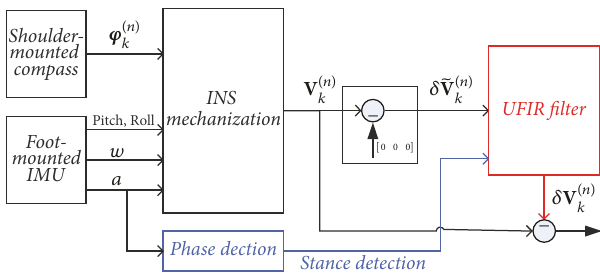
Figure 1: The architecture of the self-contained pedestrian naviga- tion using the IMU and compass